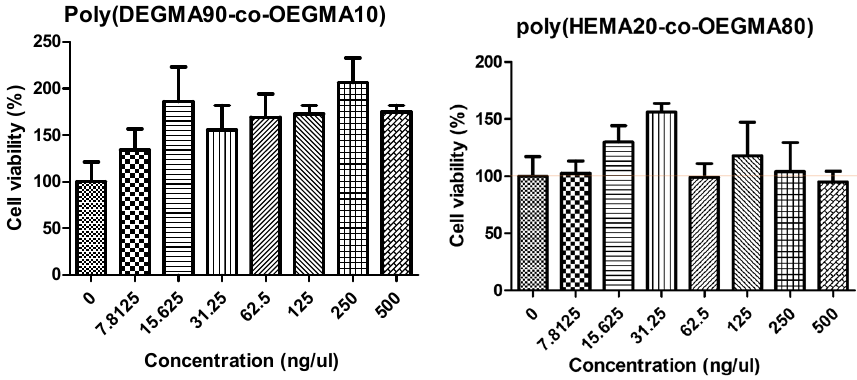
Figure 8. Result of cell viability test on MLTRPB to test the cytotoxicity.